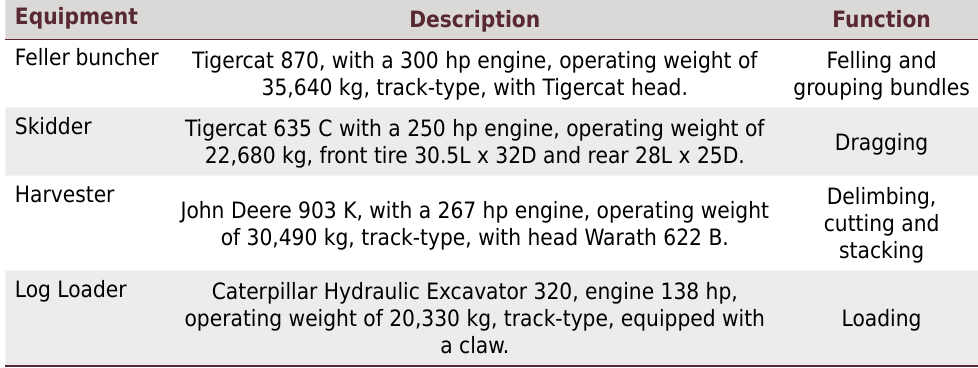
Table 1. Characteristics of the machinery used in the timber mechanized harvest in the experimental